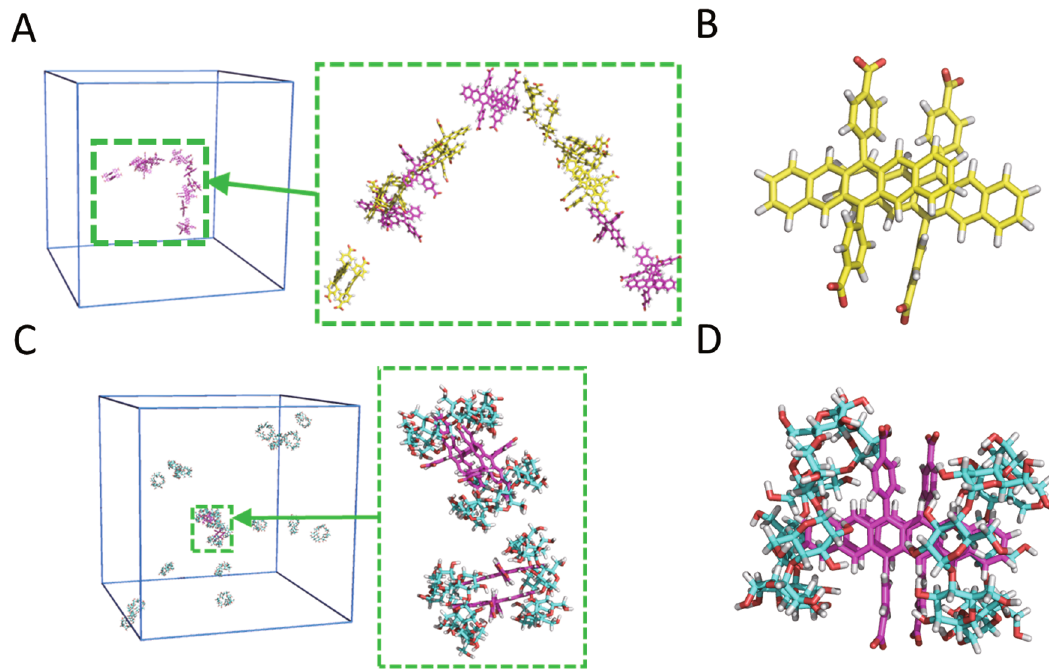
Fig.2|MDsimulationofthesupramolecularassemblies.A , B MDsimulationsnapshotsofNaPDBA([NaPDBA]=1mM)inwater-glycerol(1:1)at300K.Paralleloriented dimers are shown in yellow. C , D MD simulation snapshots of NaPDBA and γ CD ([NaPDBA]=1mM, [ γ CD]=5mM) in water-glycerol (1:1) at